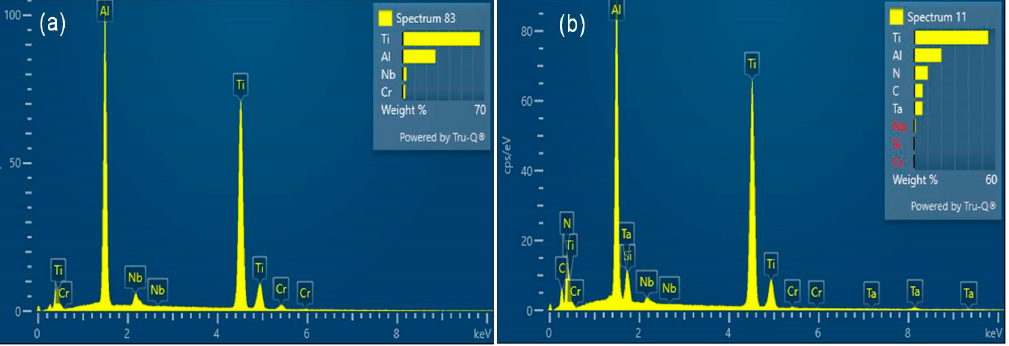
Figure 2. ESD spectrum analysis: ( a ) rectangular region denoted by 1 in Figure 1a, and ( b ) TiAl − 2 wt.% TaN. wt.%